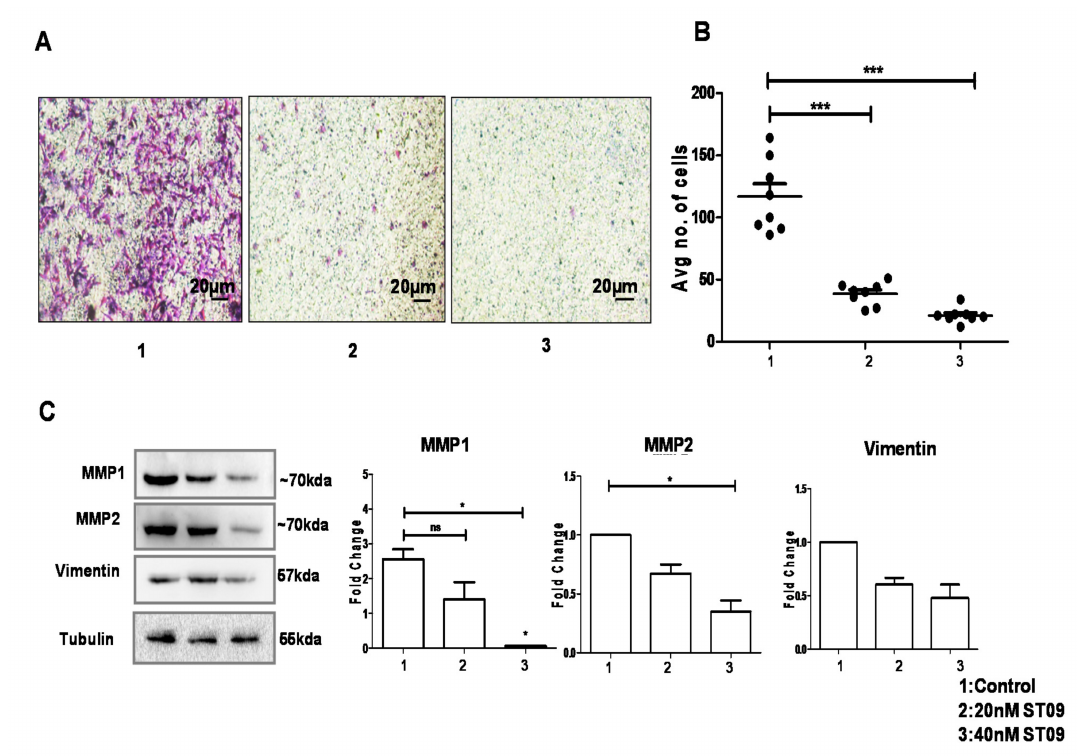
Figure 7. E ff ect of ST09 on cell migration: ( A ) ST09 treated MDA-MB-231 cells in vitro subjected to migration on Matrigel. ( B ) Quantification of migrated cells is represented as a scatter plot. ( C )